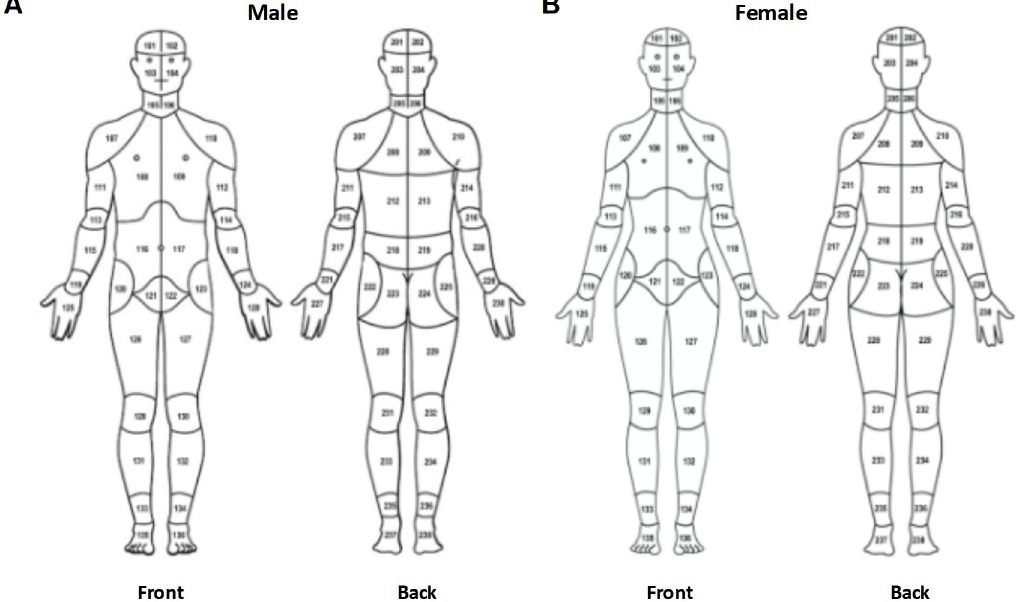
Fig 1. The (A) male and (B) female CBM with each body map area labeled with its three-digit identification